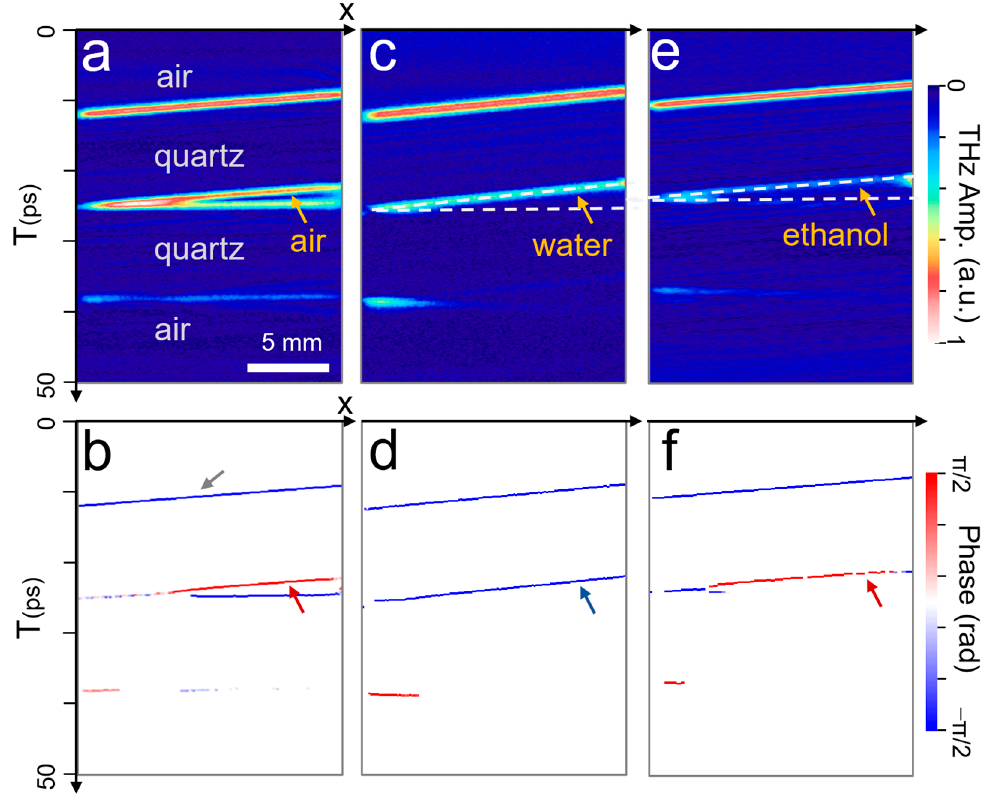
Figure 4 . ( a , b ) B-scan images for the reflected amplitude ( a ) and phase ( b ) for the samples with a tilted gap that is filled with air. ( c , d ) B-scan images for amplitude ( c ) and phase ( d ) when the gap is filled by water solution. ( e , f ) B-scan images for amplitude ( e ) and phase ( f ) when the gap is filled with ethanol whose index is lower than that of